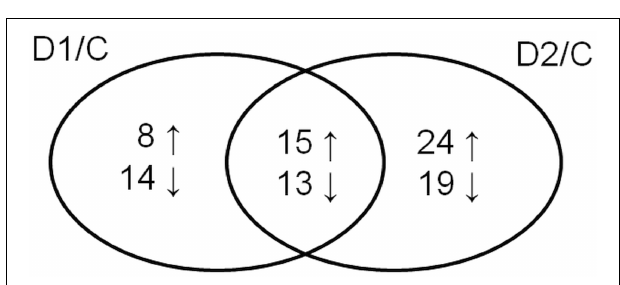
FIGURE 5 | Venn diagram showing protein spots revealing a significant increase ( ↑ ) or a decrease ( ↓ ) in drought-treated samples with respect to control ones (D1/C;